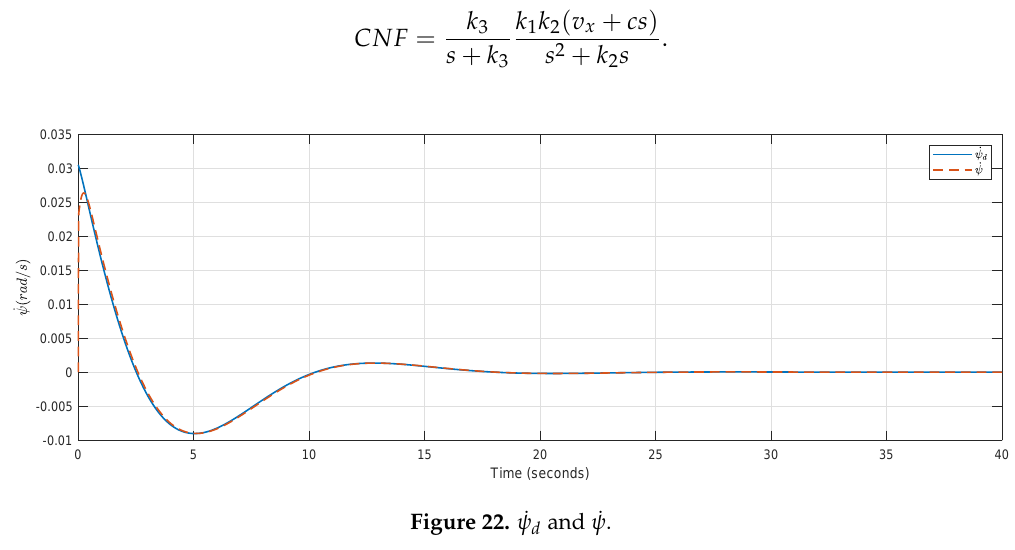
Figure 22. ˙ ψ d and ˙ ψ